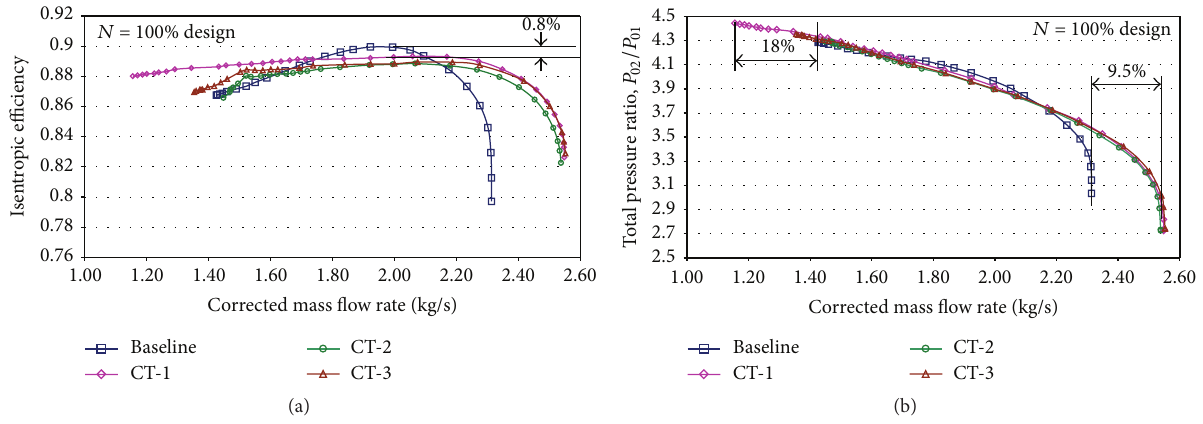
Figure 12: Overall performance characteristics of compressor without and with inducer casing treatment.